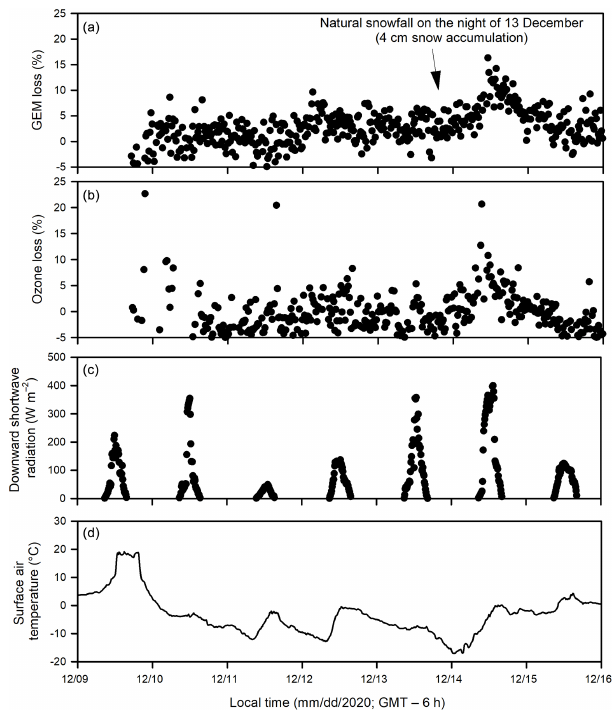
Figure 4. Temporal changes of (a) gaseous elemental mercury (GEM) loss and (b) ozone loss (measured as the difference between the UV-transmitting and UV-blocking tubes), (c) downward short- wave radiation and (d) surface air temperature during Experiment